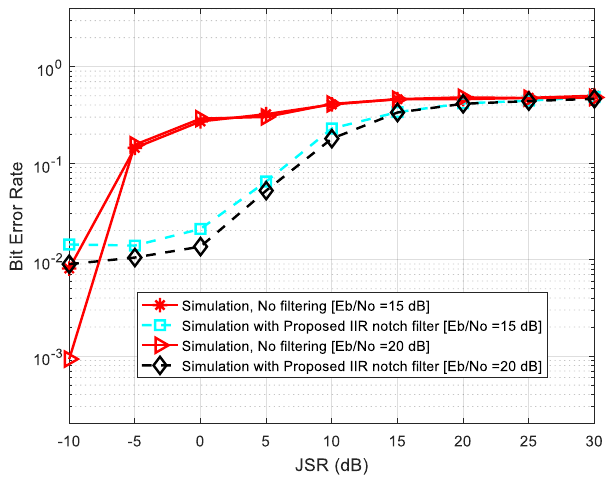
Figure 15. BER vs. JSR, using MANF.